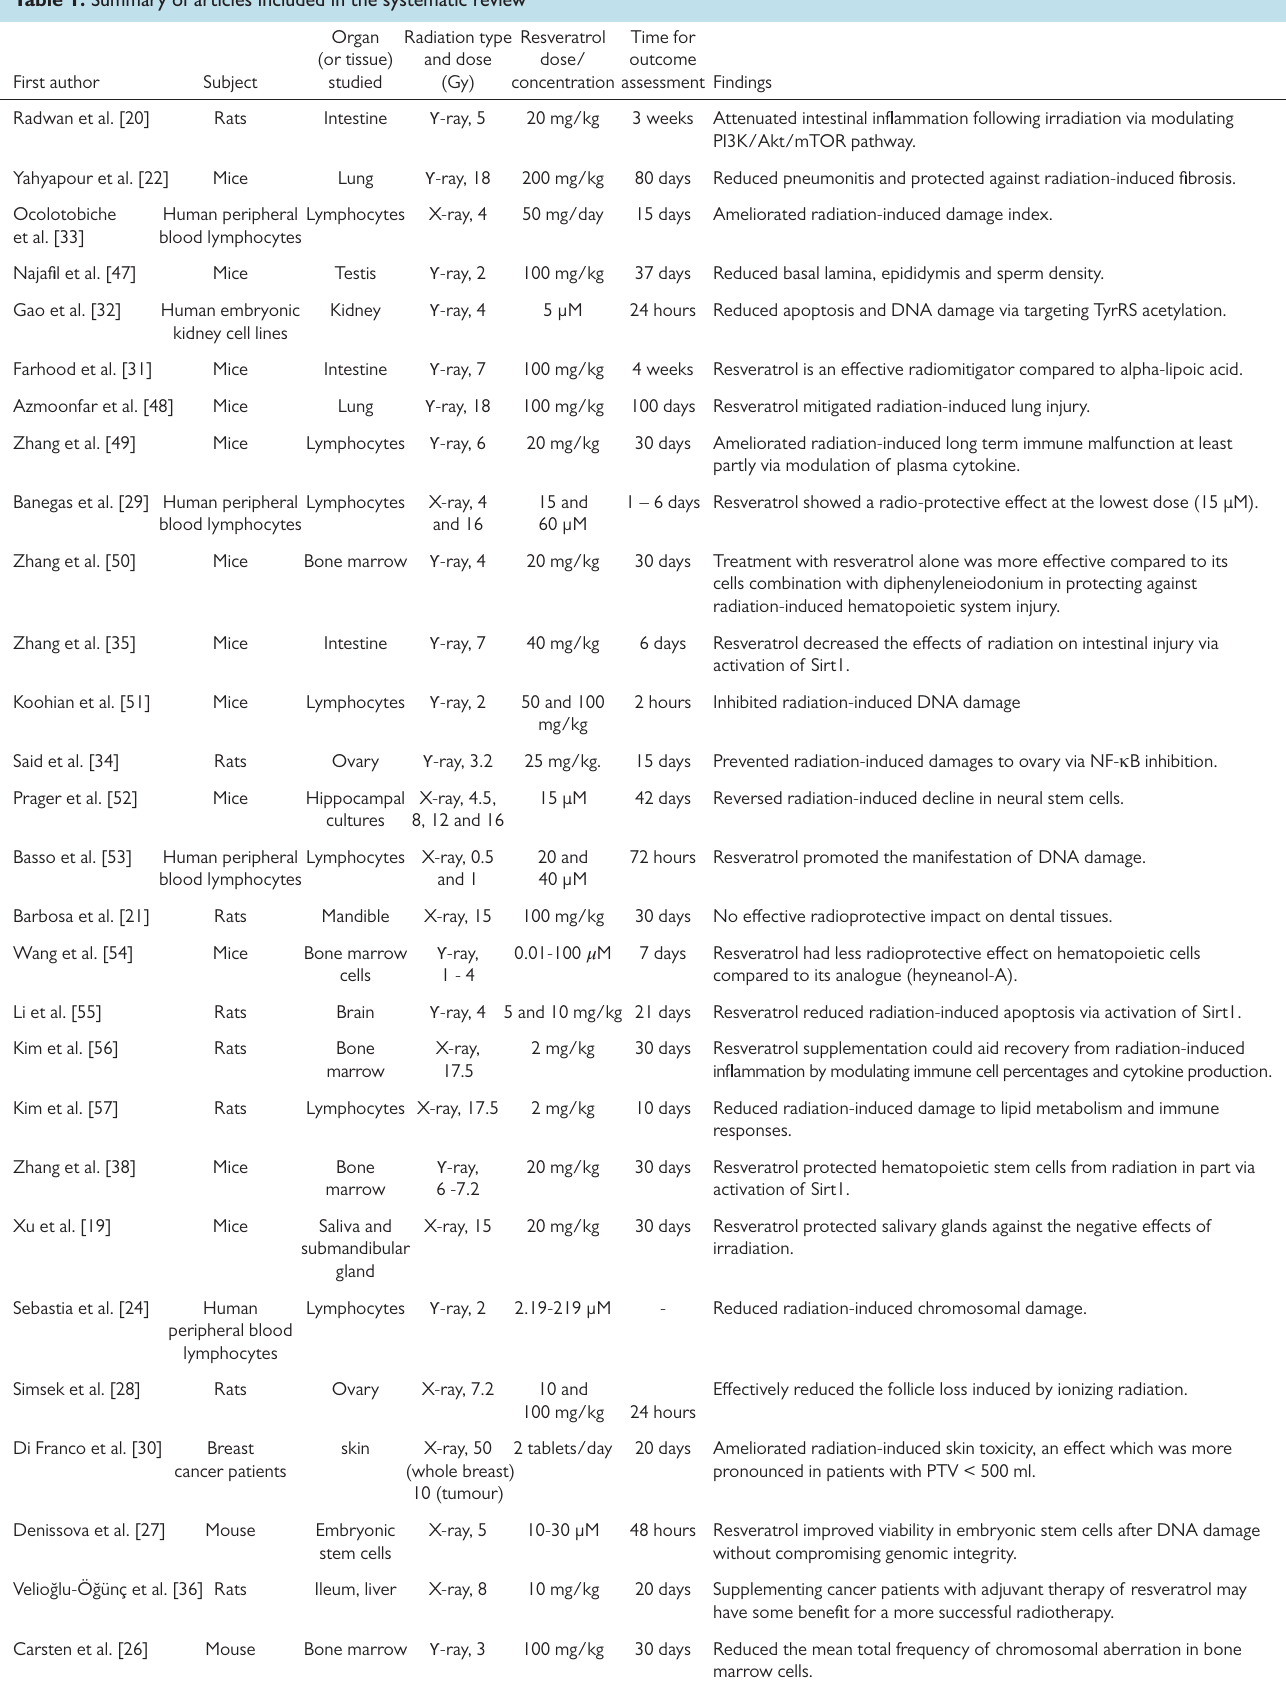
Table 1. Summary of articles included in the systematic review Organ Radiation type Resveratrol Time for (or tissue) and